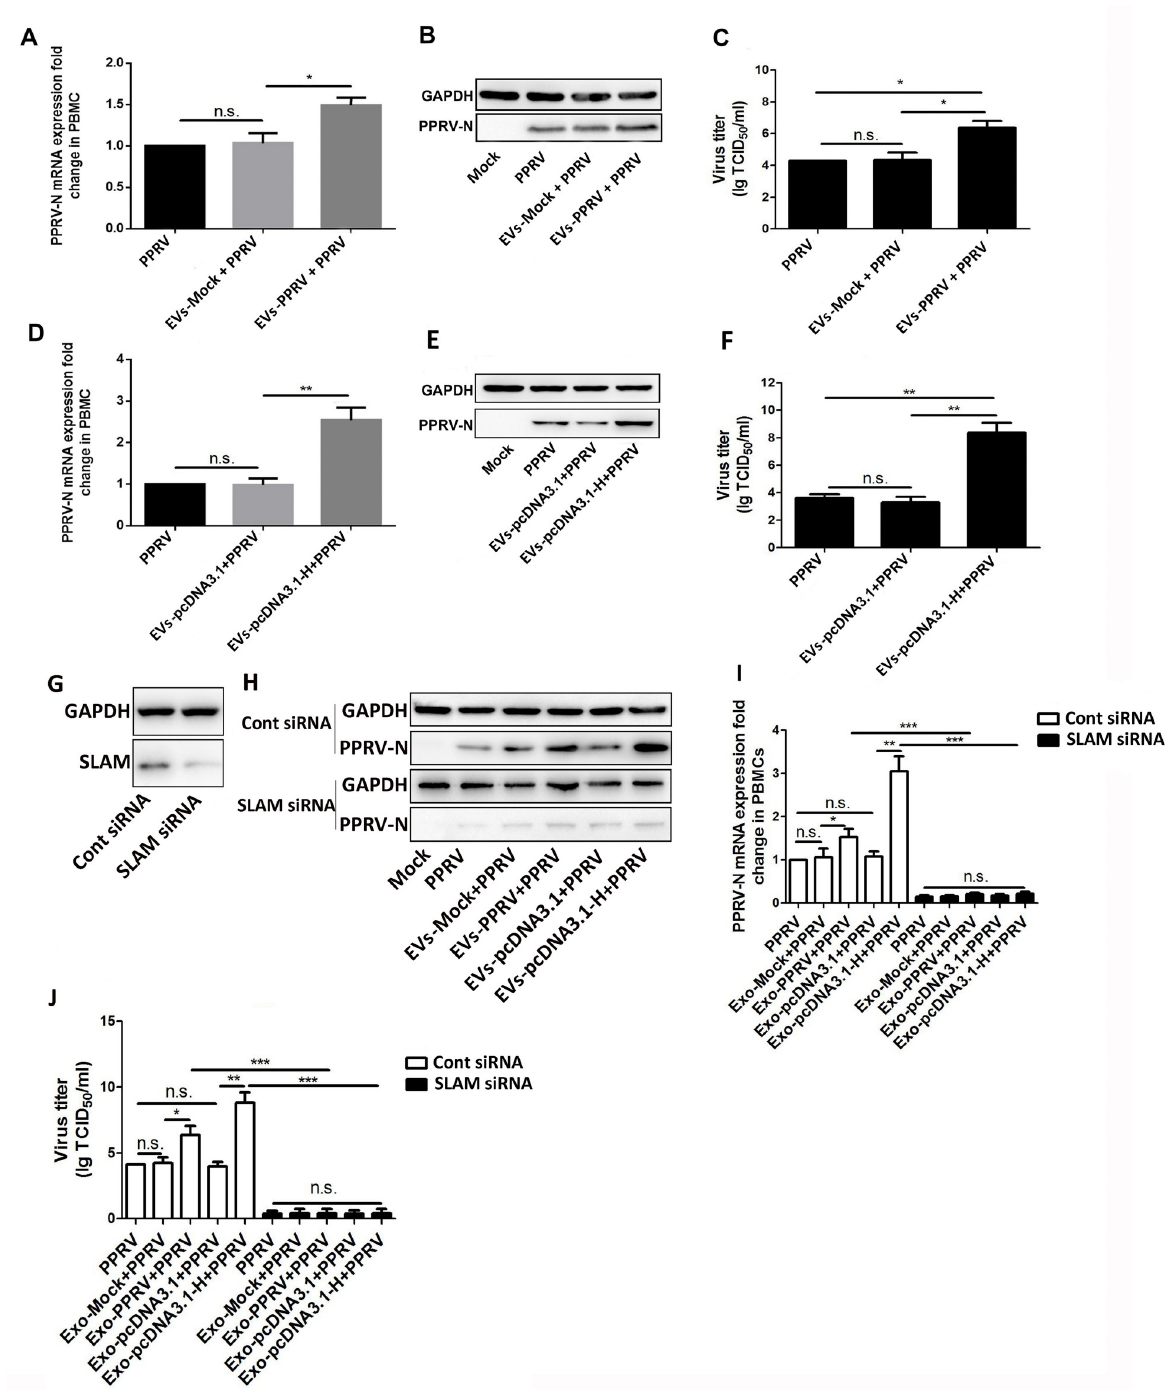
Fig 5. PPRV associate extracellular vesicles promote PPRV replication in the recipient cells. (A, B, C) Extracellular vesicles were purified from PPRV-infected (EVs-PPRV) or Mock-infected (EVs-Mock) goat PBMCs at 24 hpi and co-cultured with naive goat PBMCs for 48h. Then, the cells were infected with PPRV at an MOI of 1 for 24 h, and qRT-PCR (A), Western blot (B), and TCID 50 (C) assays were performed to determine the viral replication and progeny. (D, E, F) Extracellular vesicles were isolated from pcDNA3.1-H (EVs-pcDNA3.1-H) or pcDNA3.1 control plasmid (EVs-pcDNA3.1) transfected goat PBMCs at 24 h post transfection and co-cultured with naive goat PBMCs for 48h. Then, the cells were infected with PPRV at an MOI of 1. After 24h infection of PPRV, qRT-PCR (D), Western blot (E), and TCID 50 (F) assays were performed to determine the viral replication and progeny. (G) Western blotanalysis of SLAM expression in goat PBMCs transfected with siRNA against SLAM or scrambled